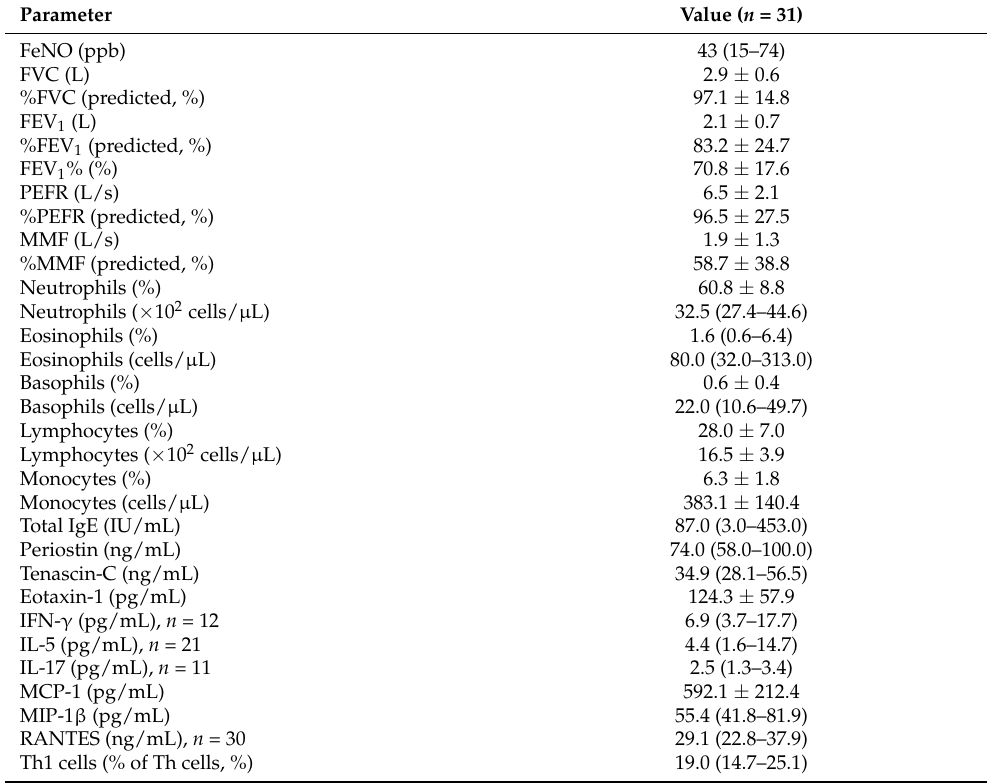
Table 2. Baseline pulmonary function and laboratory findings of the study